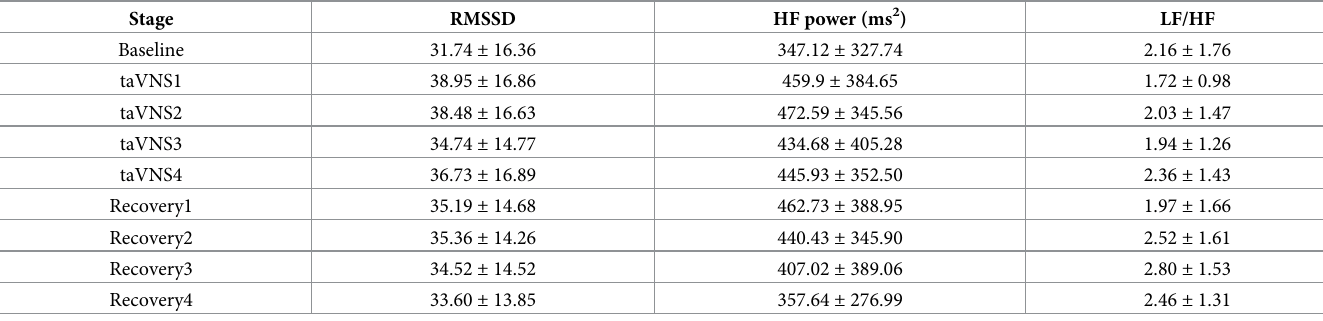
Table 5. Measurement of three HRV parameters in different